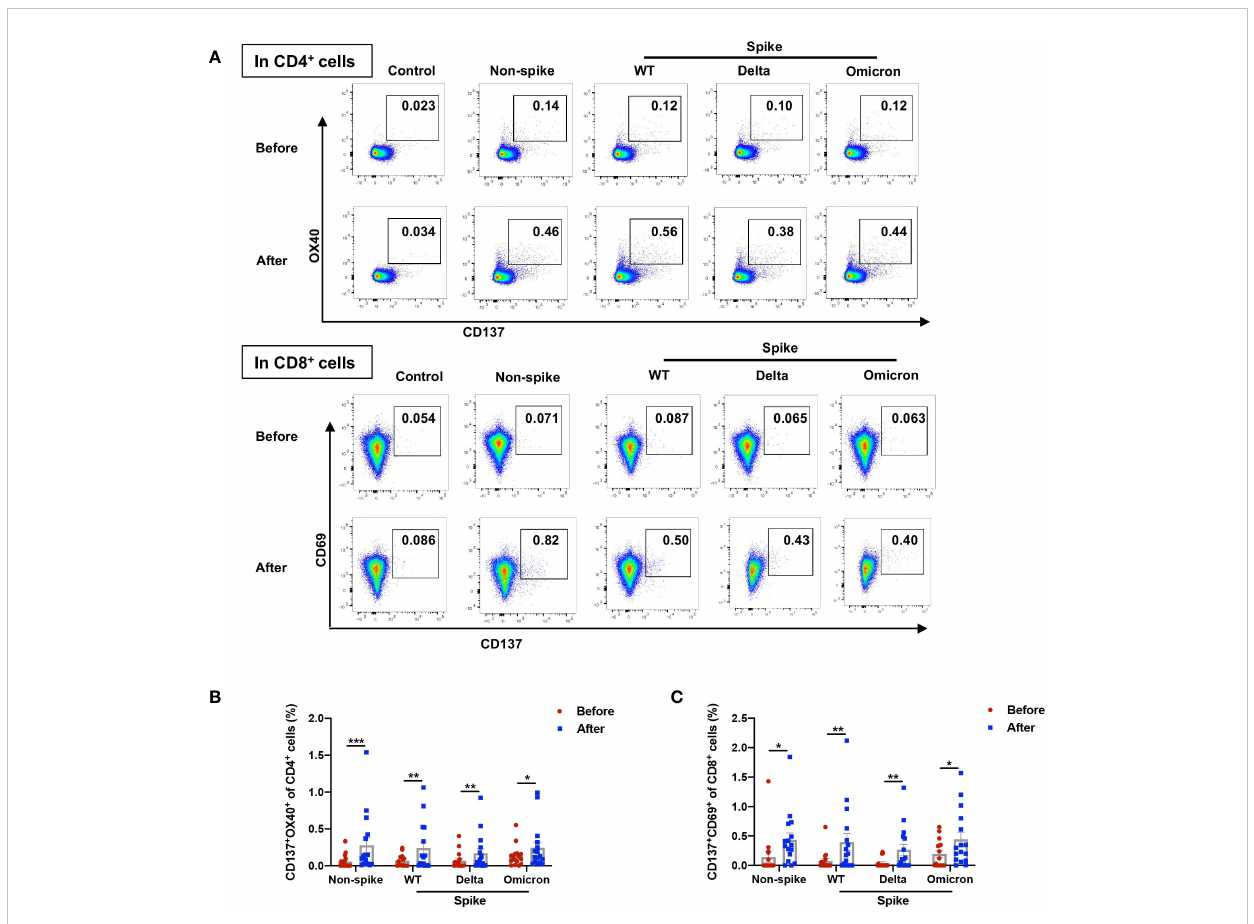
FIGURE 3 Non-spike and spike-speci fi c AIM + CD4 + and AIM + CD8 + T cell responses after a third dose of CoronaVac. PBMCs obtained before and 1-2 weeks after the third dose of CoronaVac were stimulated with spike peptide pools from WT, Delta, and Omicron as well as a non-spike peptide pool from WT SARS-CoV-2 for 20 h. The expression of AIM on CD4 + (CD137 + OX40 + ) and CD8 + (CD137 + CD69 + ) T cells was measured by fl ow cytometry. (A) Representative fl ow cytometry plots showed the frequency of AIM + CD4 + and AIM + CD8 + T cells. (B) Percentages of AIM + (CD137 + OX40 + ) cells among CD4 + T cells responding to non-spike and spike peptides were displayed. (C) Percentages of AIM + (CD137 + CD69 + ) cells among CD8 + T cells responding to non-spike and spike peptides were displayed. Each point represents raw data for a single participant. Percentages represent the percentage of T cells after subtracting the background value in a DMSO stimulation. Comparisons were performed via Wilcoxon matched-pairs signed rank test between two groups or Friedman test with Dunn ’ s multiple comparisons test among multiple groups. n = 16. * p < 0.05, ** p < 0.01, *** p <